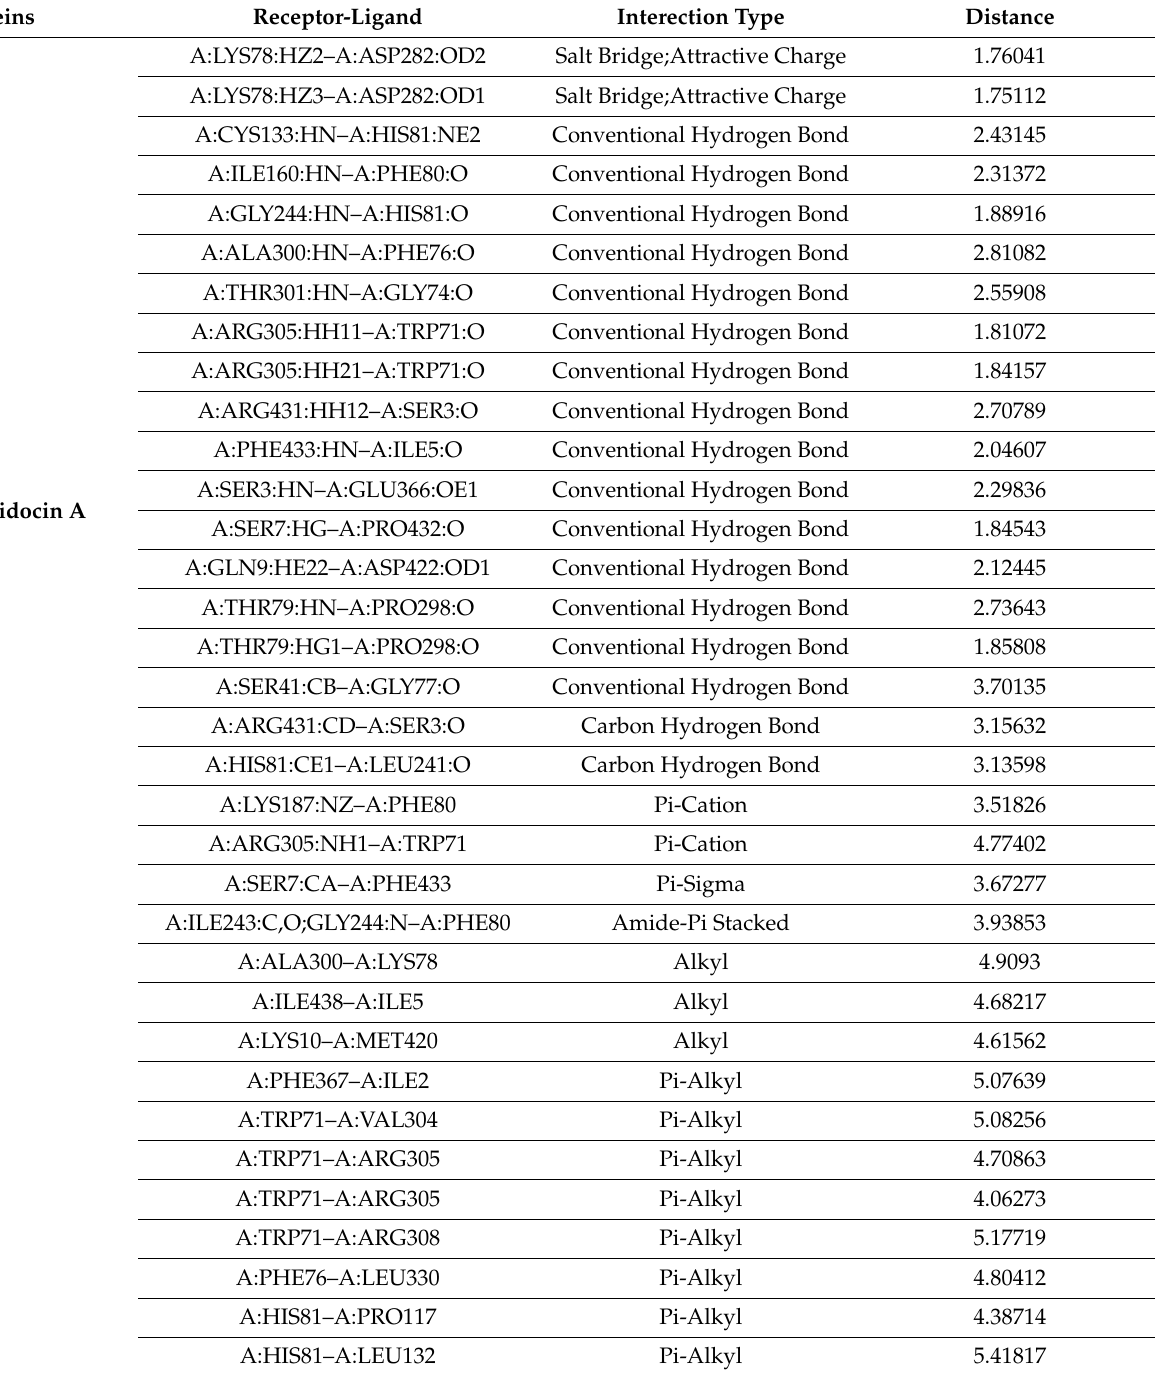
Table 2. Interacting active site residues of acidocin A with different target proteins. Proteins Receptor-Ligand Interection Type Distance Salt Bridge;Attractive